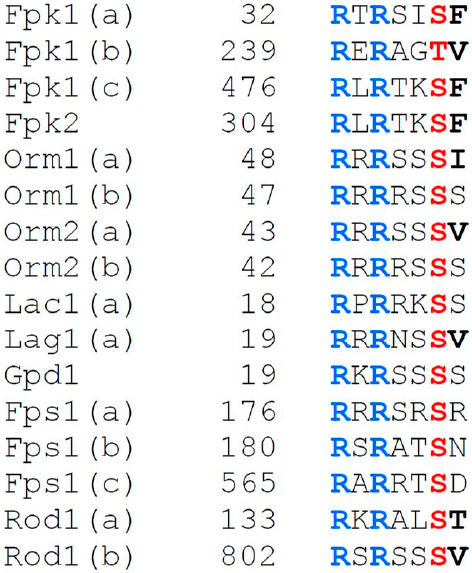
Figure 6. Selected sites of Ypk1 phosphorylation. The phospho-acceptor sites in the indicated gene products (position of first residue in the sequence shown indicated on the left) were validated as authentic Ypk1 phosphorylation sites both in vitro and in vivo. Documentation for these assignments can be found in the following publications: Fpk1 and Fpk2 [52]; Orm1 and Orm2 [22]; Lac1 and Lag1 [23]; Gpd1 [137]; Fps1 [24]; and, Rod1